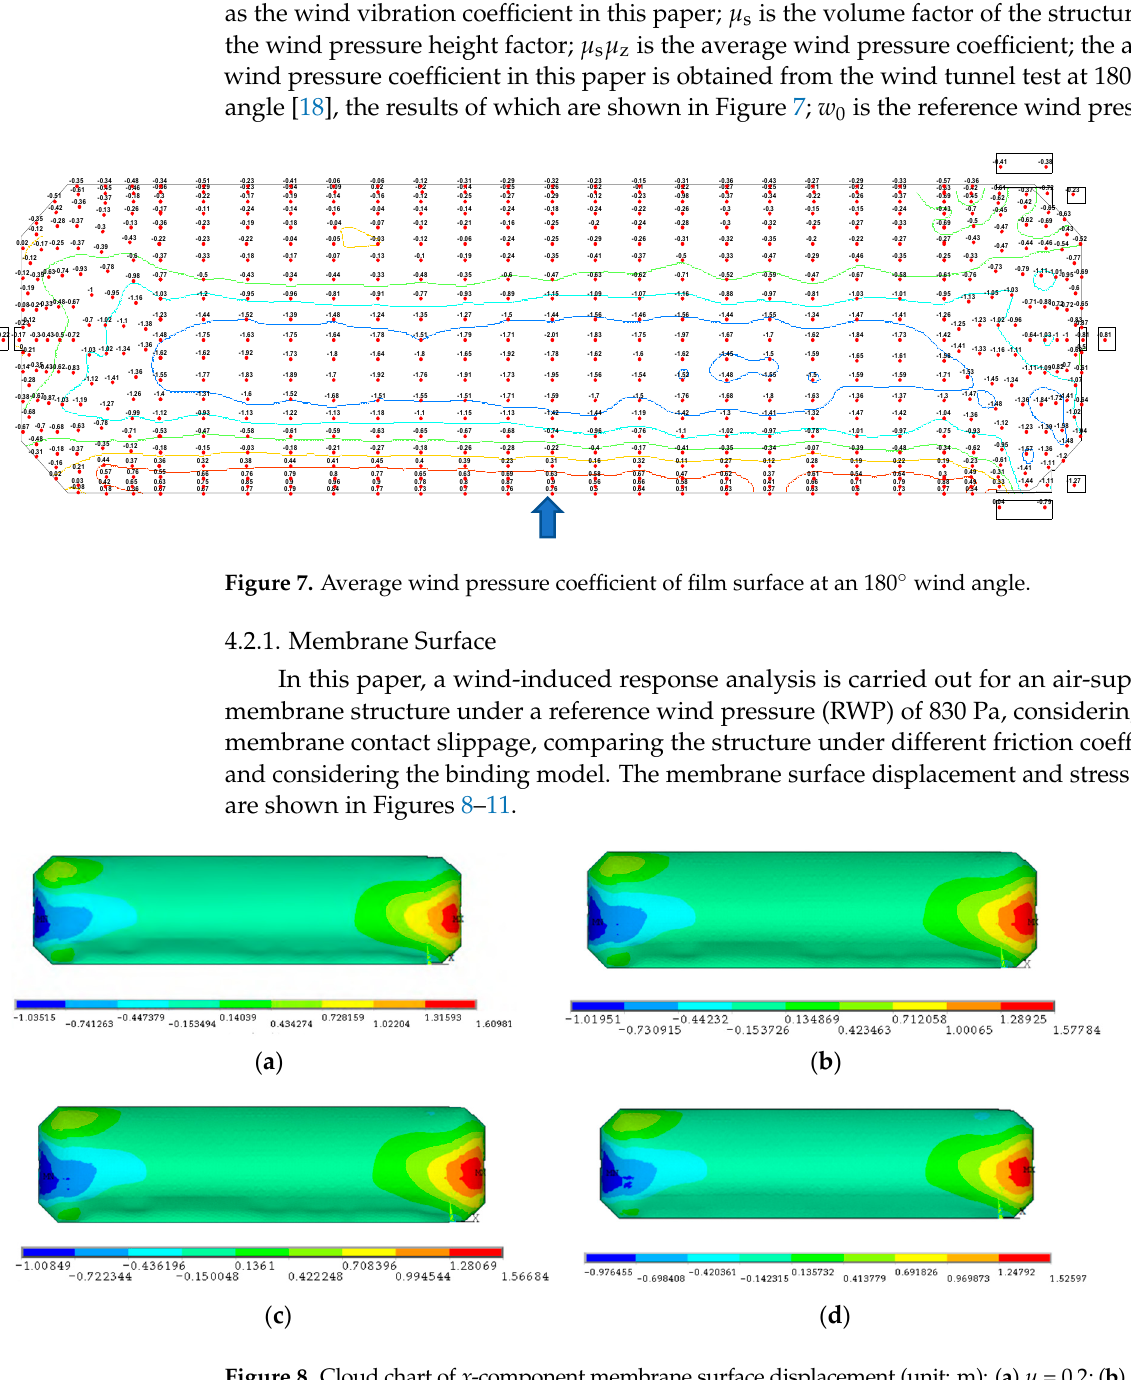
( d ) Figure 9. Cloud chart of y -component membrane surface displacement (unit: m): ( a ) μ = 0.2; ( b ) μ = 0.44; ( c ) μ = 0.68; and ( d ) μ = ∞ *. ( a ) ( b ) ( c ) ( d ) Figure 10. Cloud chart of z -component membrane surface displacement (unit: m): ( a ) μ = 0.2; ( b ) μ = 0.44; ( c ) μ = 0.68; and ( d ) μ = ∞ *.